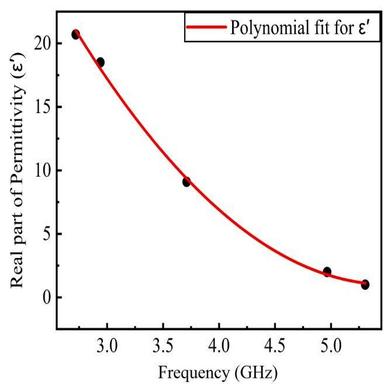
Fitting for the real part of permittivity (ε′ r).